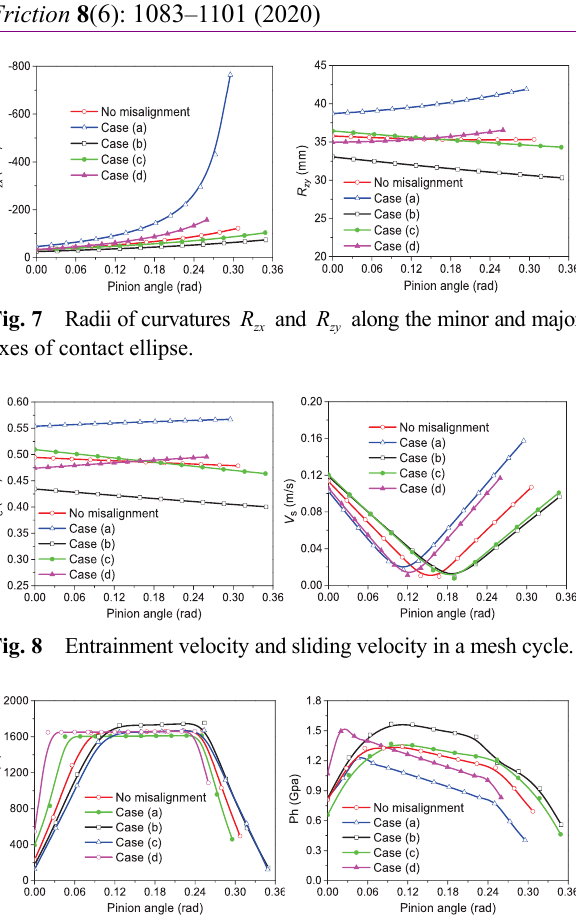
Fig. 9 Contact load and the maximum Hertzian pressure under different error combinations.